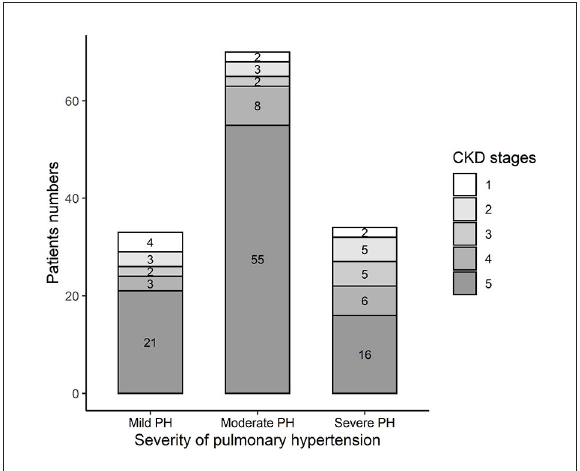
FIGURE2 Distribution of different CKD stage in different PH severity groups in the study cohort. Mild vs. Moderate: p = 0.233; Mild vs. Severe: p = 0.391; Moderate vs. Severe: p = 0.014.